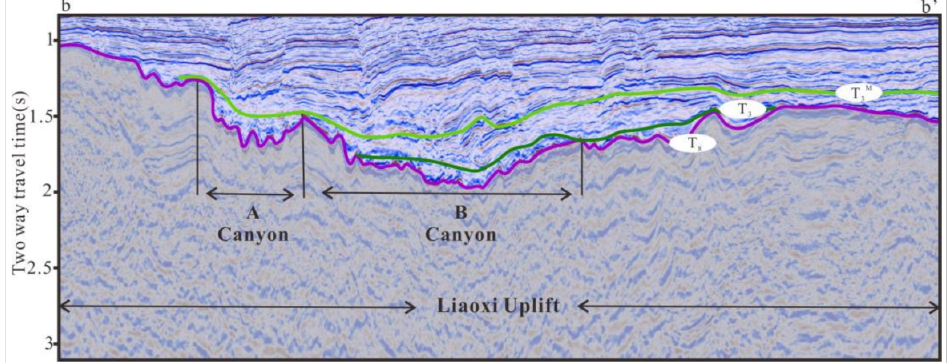
Figure 11. Seismic section along Liaoxi uplift. There are two canyons on the uplift, and the Shahejie strata developed in the canyons. Annotation: A and B are the numbers of canyons; b-b’ is the number of seismic section. Figure 1C shows